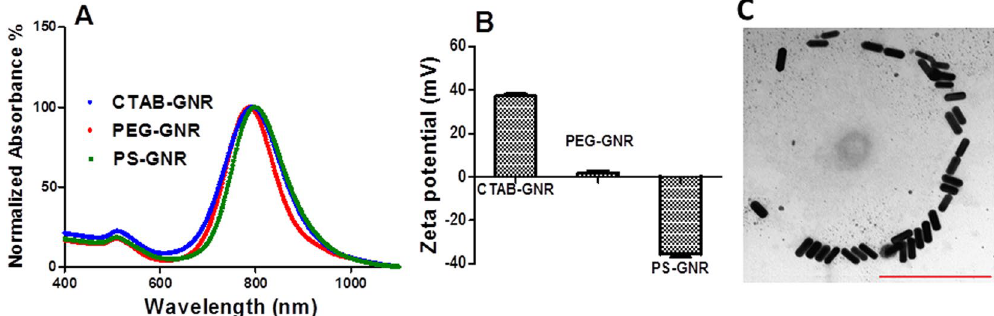
Figure 1. Characterization of GNR of different surface chemistry as labelled. ( A ) UV-vis absorption spectra of GNR suspensions. ( B ) Effective surface charge of GNR functionalized with different ligands. ( C ) TEM image of PEG-GNR features lengths of 38.2 ± 1.8 nm and widths of 10.1 ± 0.8 nm. Scale bar = 500